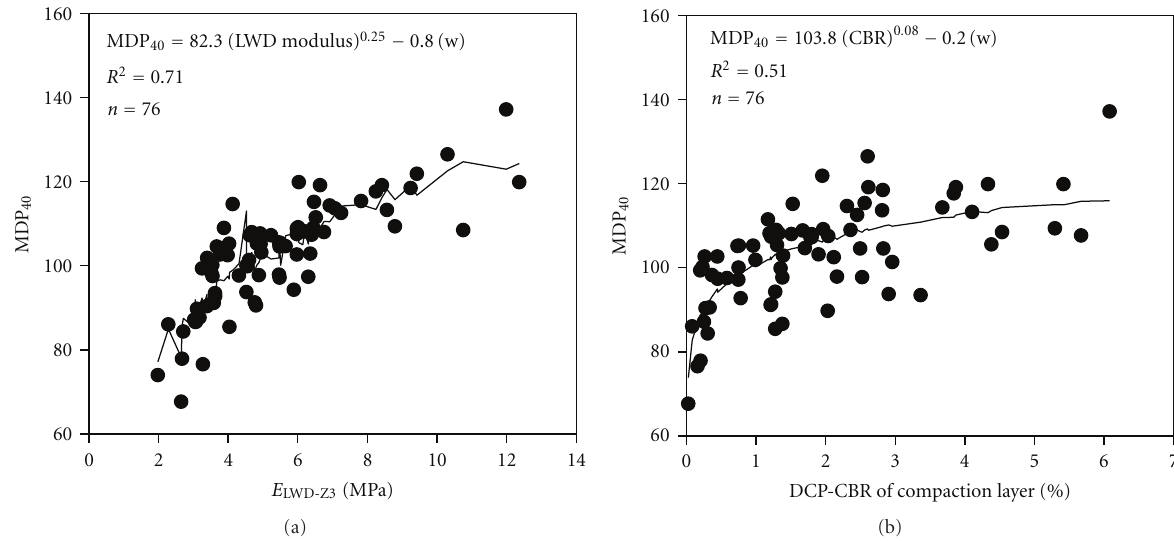
Figure 5: Example 4: Multivariate non-linear regression analysis between MDP 40 and in situ point measurements (LWD modulus and CBR determined from DCP) using moisture content—Sandy clay to silty clay